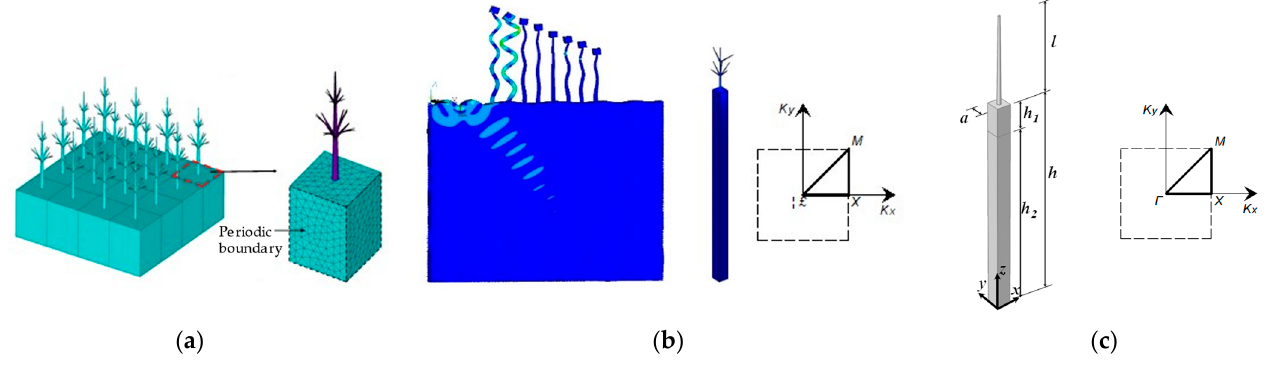
( c ) Figure 5. Several periodic lattices of NMs: ( a ) triangle lattice; ( b ) rectangular lattice; ( c ) square lat- tice. 2.2.1. Bandgaps of Bragg Scattering In fact, Bragg scattering bandgaps (BSBs) were discovered a few decades ago by Brillouin in 1953. These bandgaps were created by acoustic waves dispersing in a man- ner similar to the way that X-rays are scattered by periodic patterns in Bragg scattering. This form of bandgap is most typically created at frequencies in the infrasonic or super- sonic range, in which the wavelength is so significantly bigger than that of the lattice constant that the scatterers’ material qualities will have an impact [95]. Kushwaha et al. [142] demonstrated the bandgaps of pure S-waves with an out-of-plane polarization as